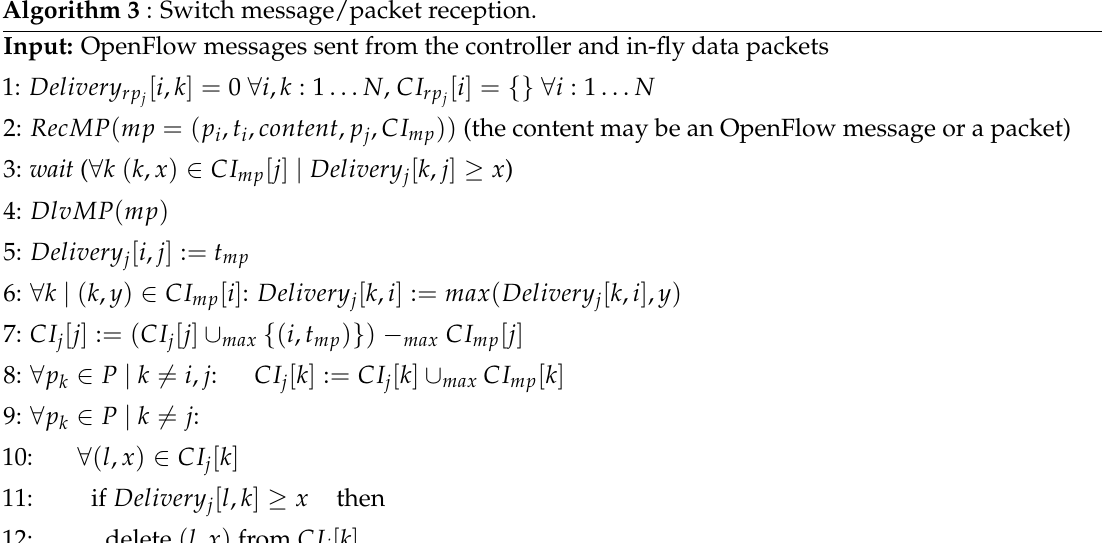
Algorithm 3 : Switch message/packet